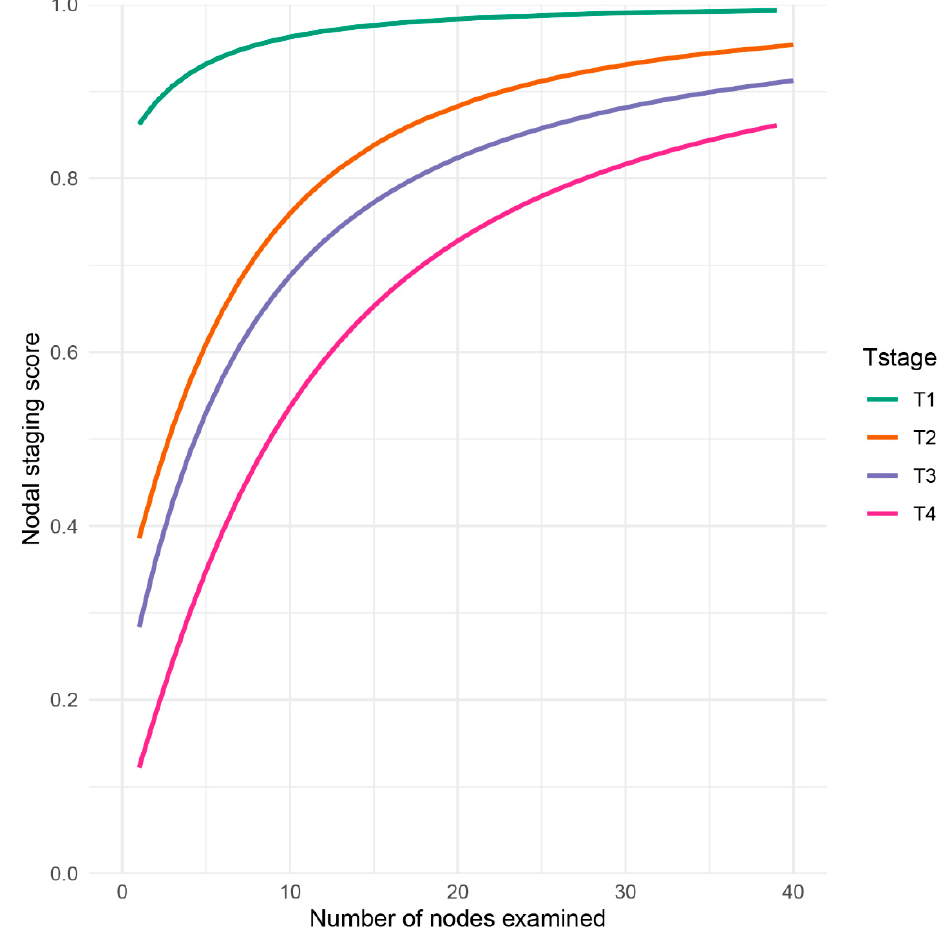
Figure 3. Nodal staging score (NSS) as a function of examined lymph node in GSRCC patients. NSS was displayed and stratified by T stage .